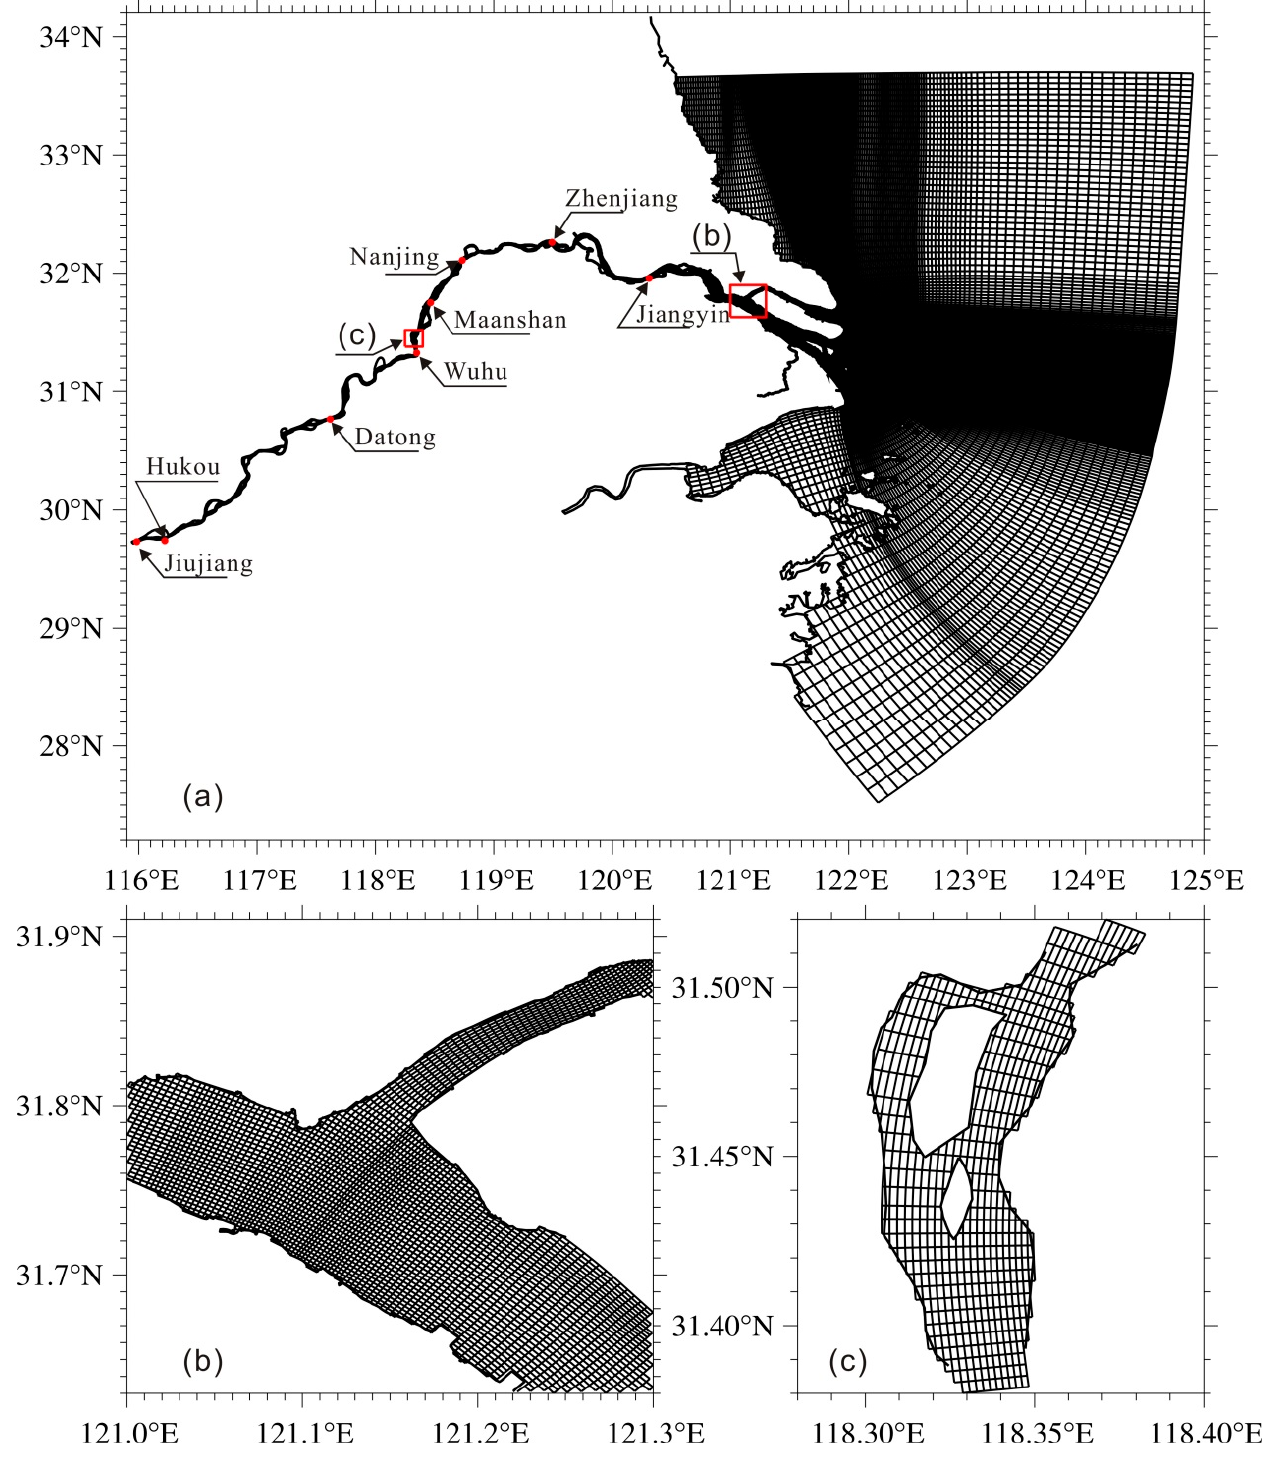
Figure 2. Model domain and grid ( a ), enlarged views of the model grid at the bifurcation between the North Branch and South Branch ( b ) and in the river near Wuhu ( c ).